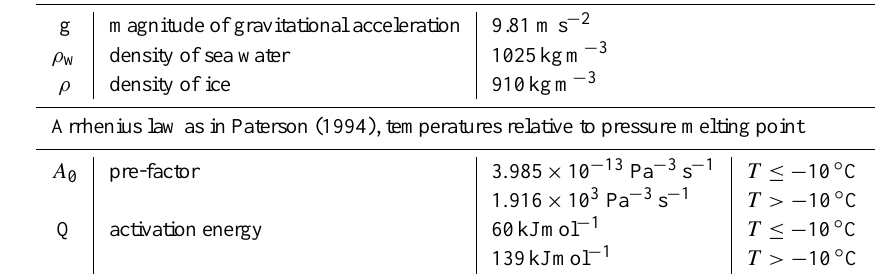
Table 1. Numerical parameters used in this